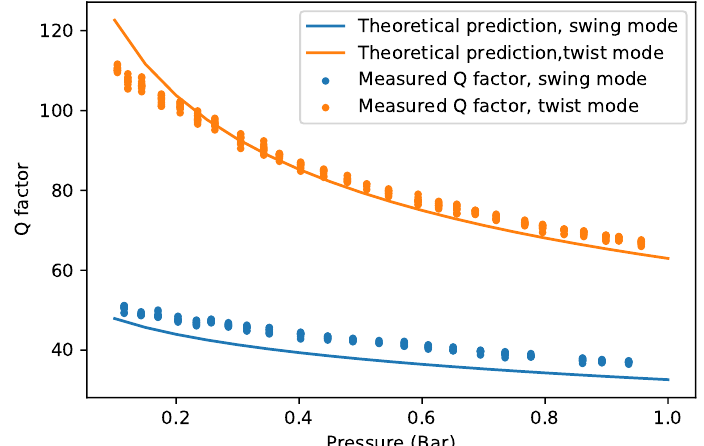
Figure 12. Measured and theoretically predicted Q factor of device (c) for the swing mode as a function of pressure.